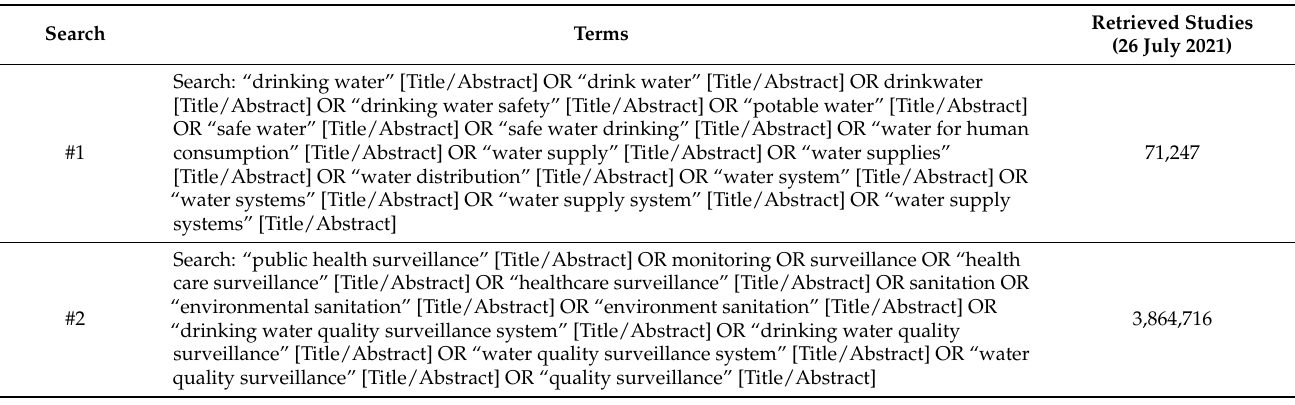
Table A1. Complete strategy for the search in